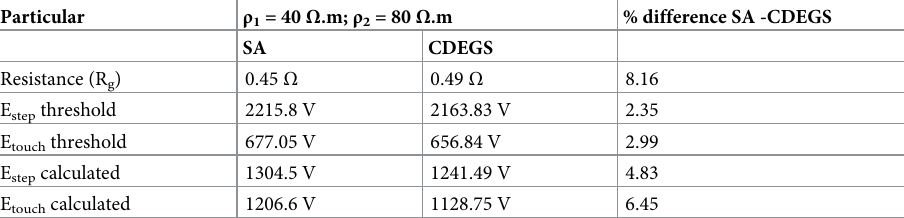
Table 12. Results for grounding system in vertical two-layer soil ( ρ 1 < ρ 2 ).